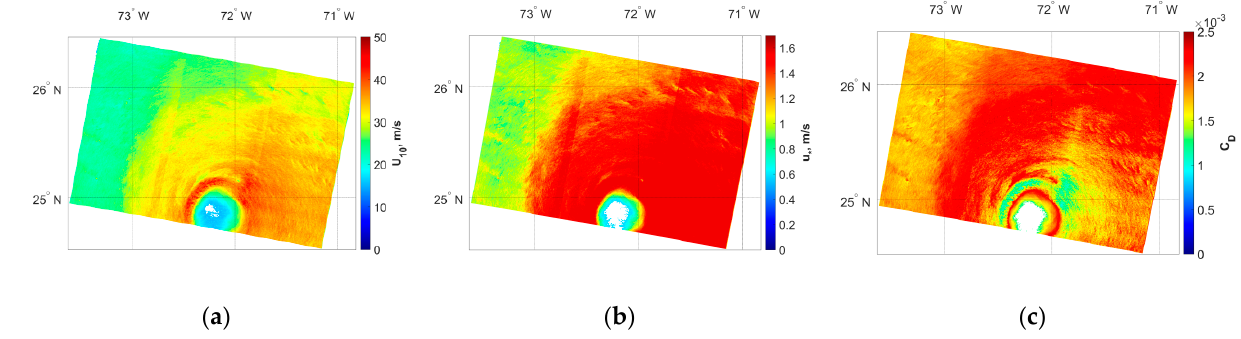
Figure 10. Illustration of the distributions of U 10 ( a ), u ∗ ( b ) and C D ( c ) retrieved from the Hurricane Maria SAR image of 23 September 2017.